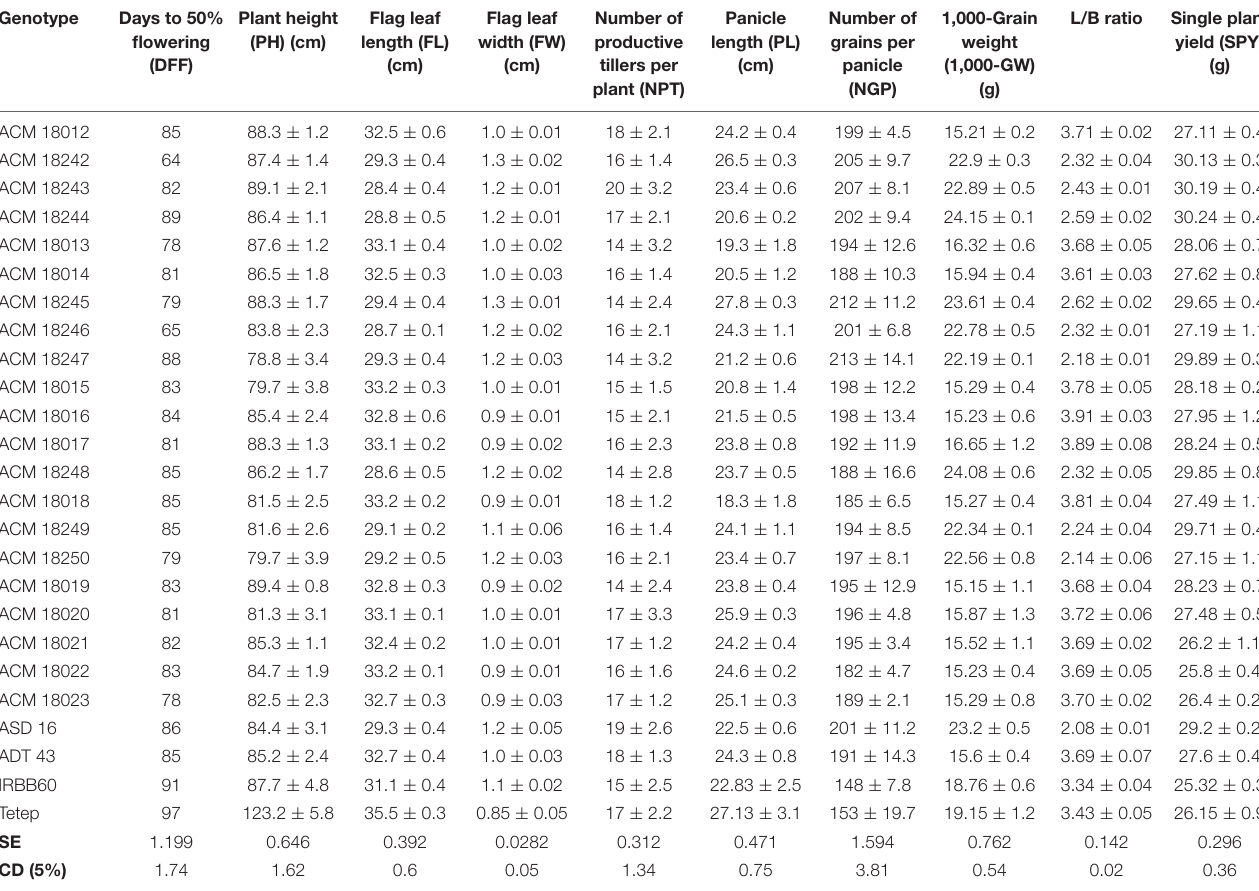
TABLE 3 | Agro-morphological characters of selected improved pyramided lines at BC 3 F 3 generation.